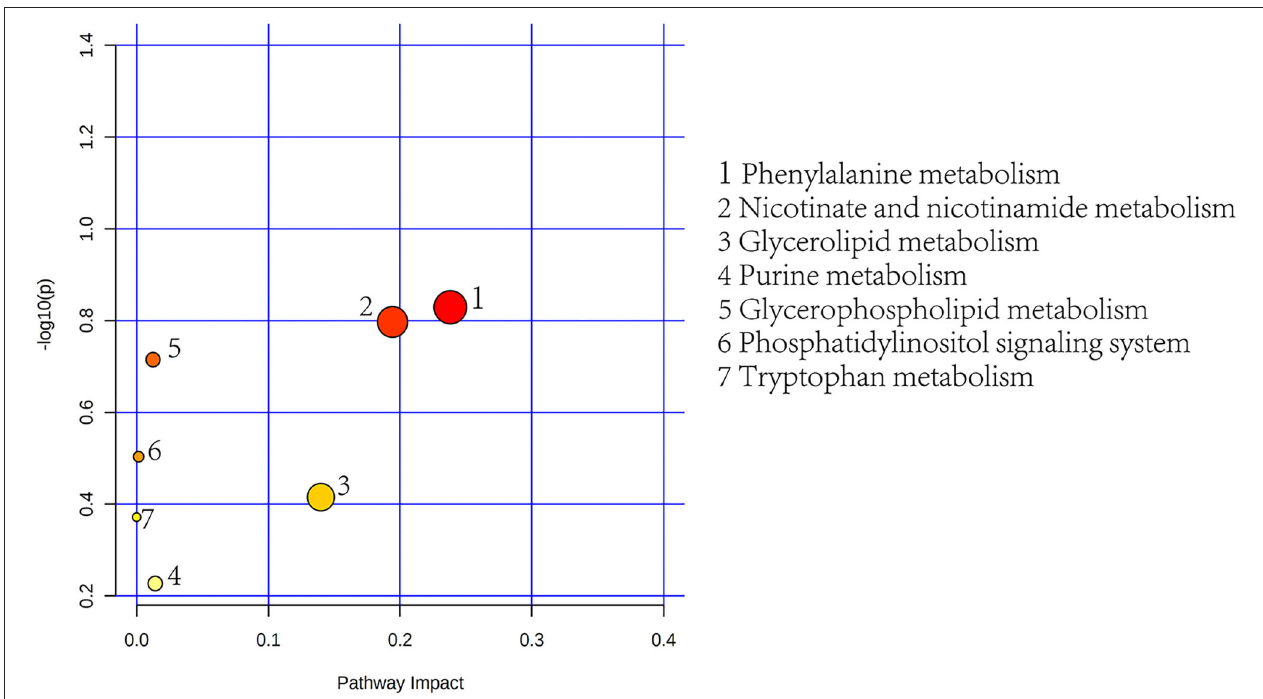
FIGURE 9 | Feces metabolic pathway analysis using MetaboAnalyst 5.0 (http://www.metaboanalyst.ca). x -Axis, pathway impact; y -axis, –log( p ). Circles represent metabolic pathways. Darker circles indicate more significant changes in the metabolites in the corresponding pathway, whereas the size of the circle corresponds to the pathway impact